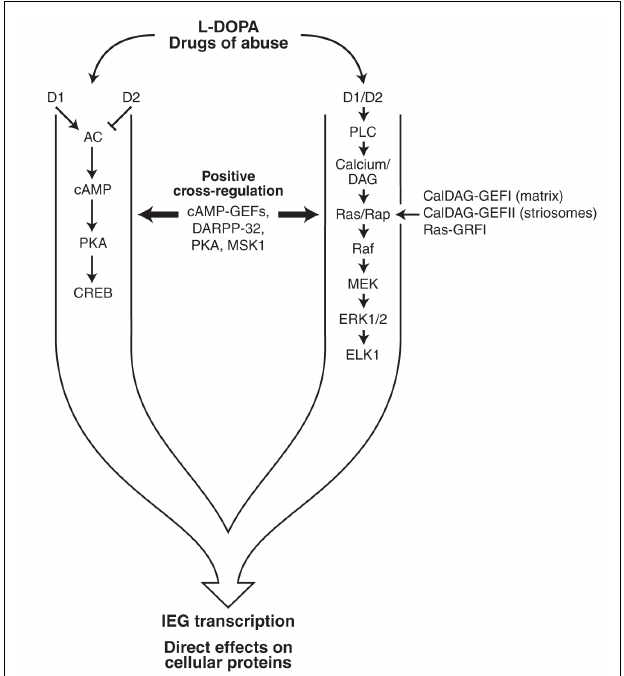
FIGURE 2 | Simplified diagram of the protein kinaseA (PKA) and extracellular signal-regulated kinase/mitogen-activated protein kinase (ERK1/2; MAPK) signaling cascades. Both PKA and ERK cascades control neuronal activity and immediate early gene (IEG) expression in medium spiny projection neurons of the striatum. D1 dopamine receptors promote the PKA cascade by activating adenylyl cyclase (AC) whereas D2 dopamine receptors inhibit AC. D1/D2 heterodimers are positively coupled to phospholipase C (PLC).The calcium- and diacylglycerol-regulated guanine nucleotide exchange factors (CalDAG-GEFs), which regulate the ERK1/2 cascade, are differentially expressed in the striosome and matrix compartments. Imbalances in striosome vs. matrix (IEG) transcription are implicated in L-DOPA-induced dyskinesias and drug